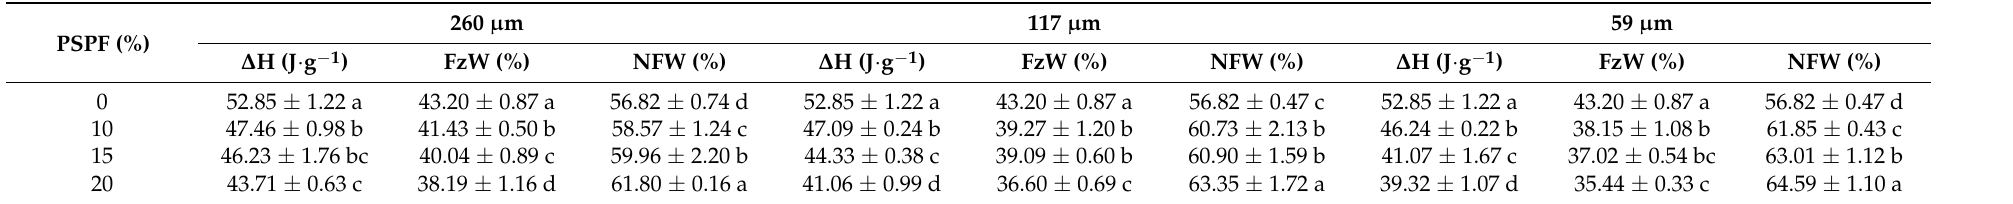
Table 5. Melting enthalpy, freezable water, and non-freezable water content of PSPD.